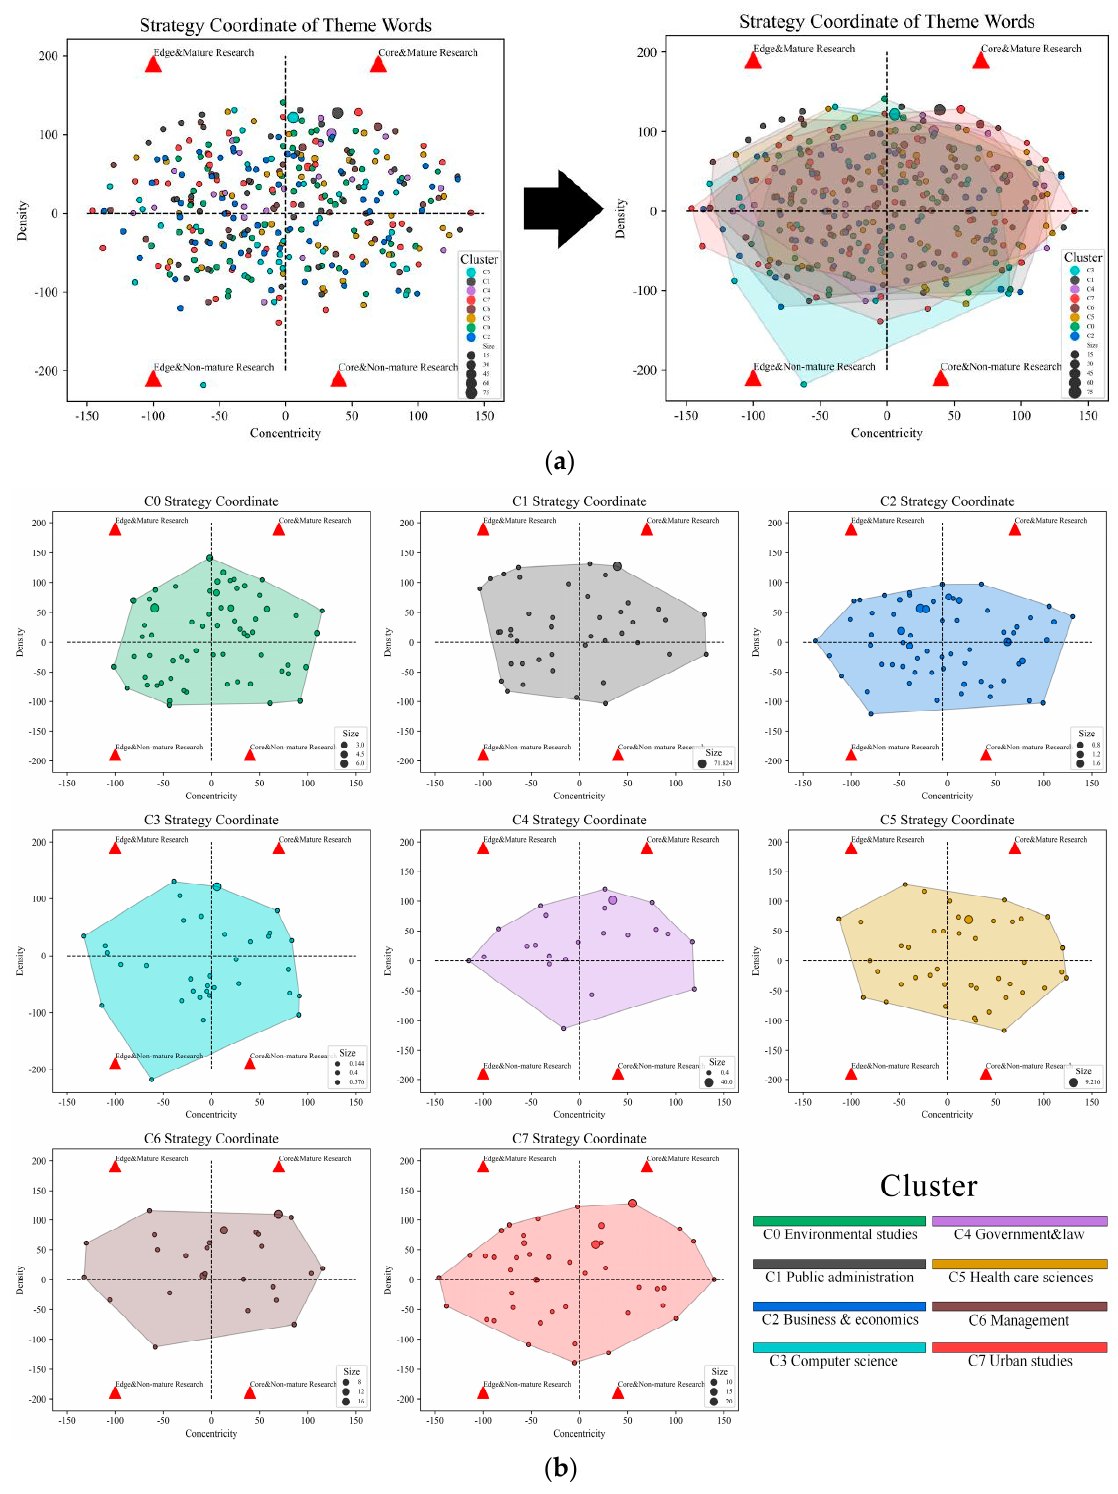
Figure 12. Strategic Coordinate Evolution of Theme Word ( a ) Macro Evolution of Core Themes; ( b ) Microscopic Evolution of Core Themes. ( b ) Microscopic Evolution of Core